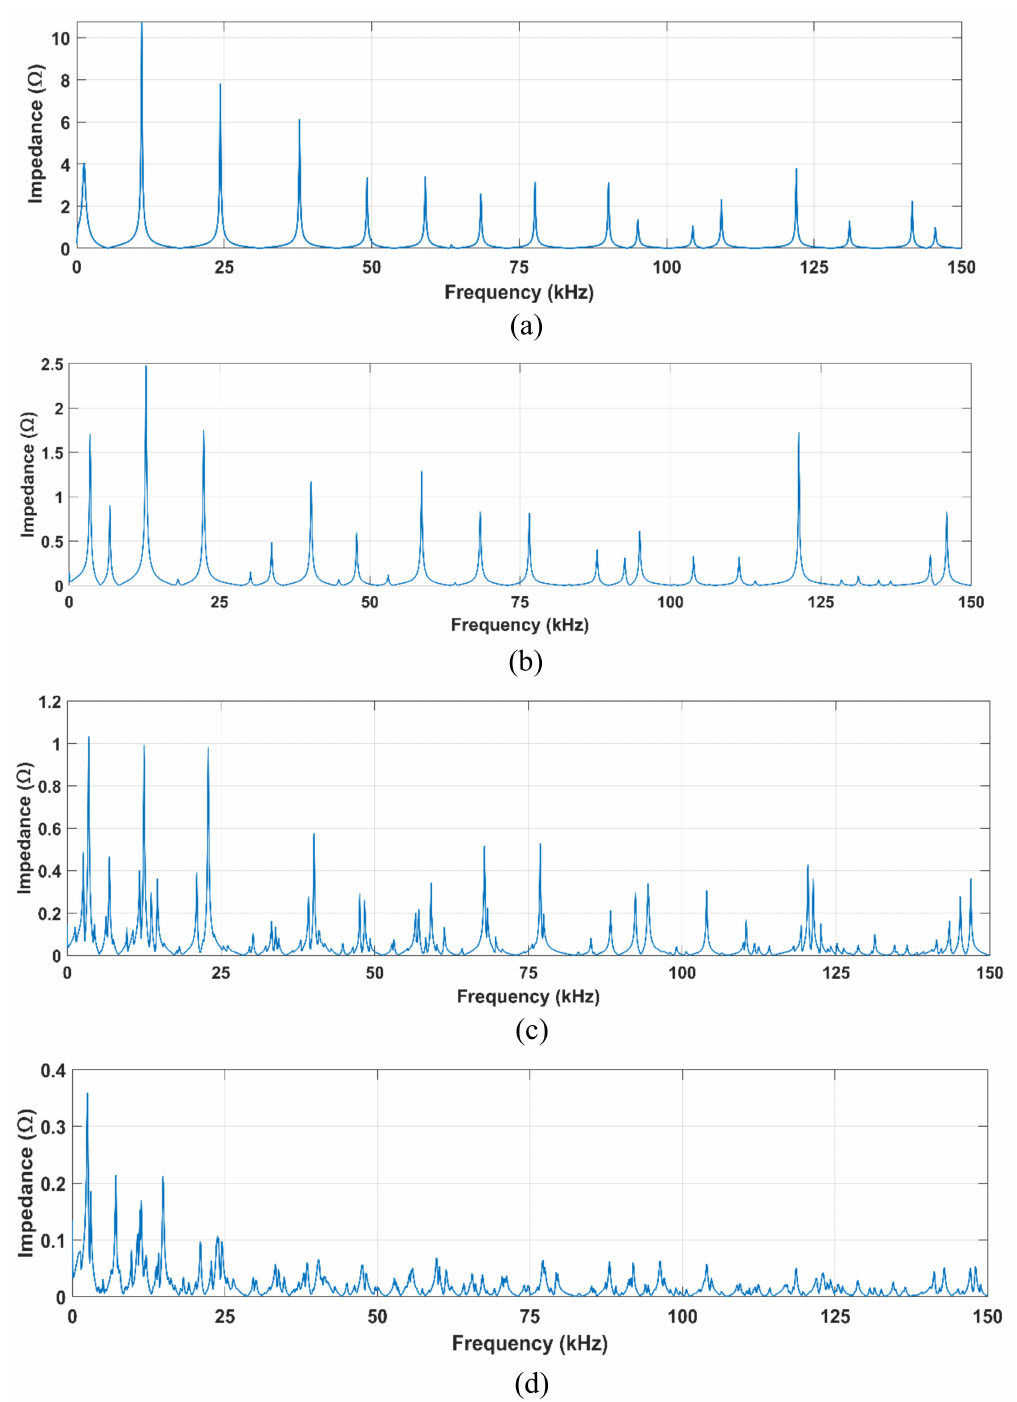
Table 1. The input impedance obtained by a frequency scan at node 1 with four different feeder configurations with skin effect is shown in Figure 7.